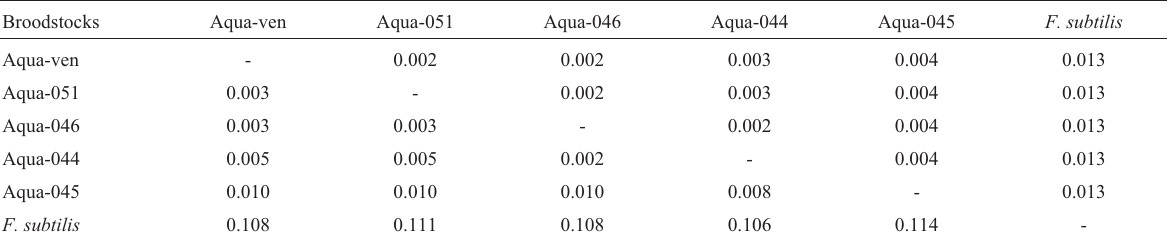
Table 1 - Genetic distance (lower diagonal) and standard deviation values (upper diagonal) obtained from COI gene sequence analysis.